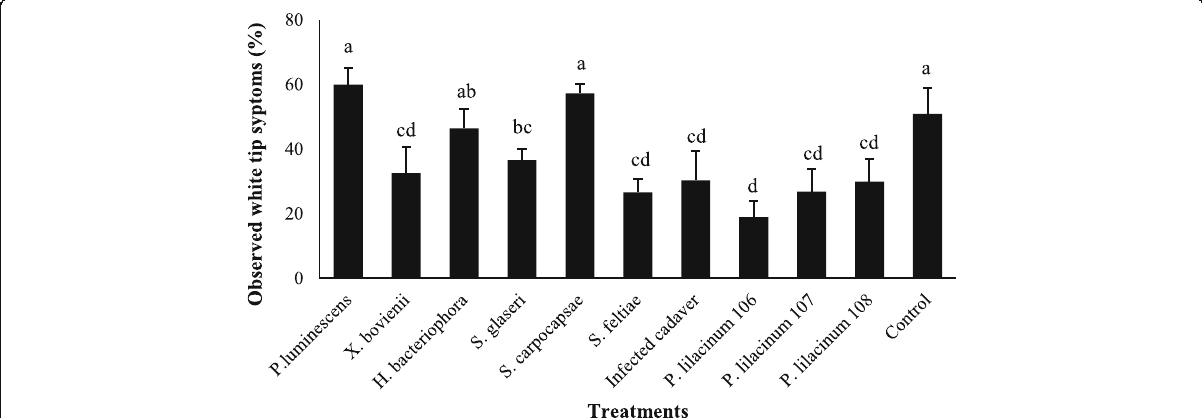
Fig. 1 The effect of treatments on the percentage of white tip symptoms observed on the rice plants. Differences were significant at P < 0.05, and the same letters are not significantly different